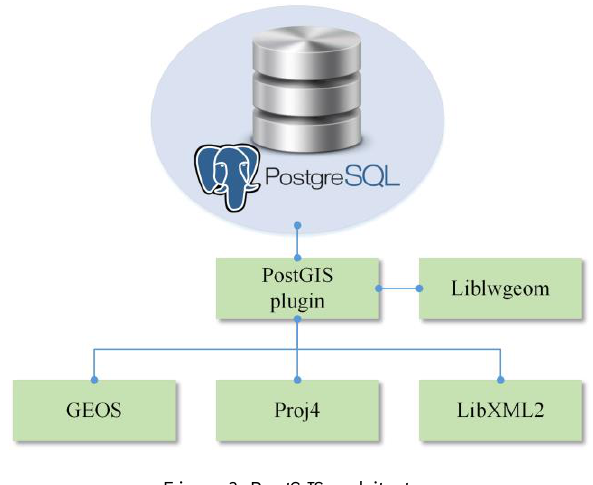
Figure 3: PostGIS architecture